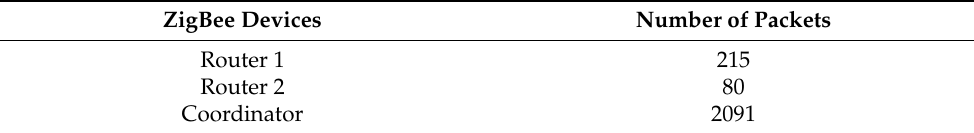
Figure 14. ZigBee coverage for the golf course. Table 4. Unique packets received by each ZigBee router and